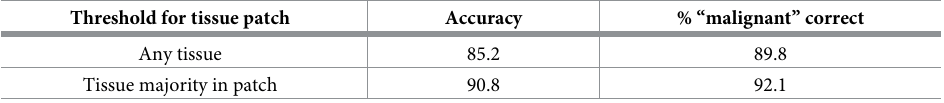
Table 3. Accuracy and percentage of “malignant” slides correctly classified according to threshold of tissue used in training